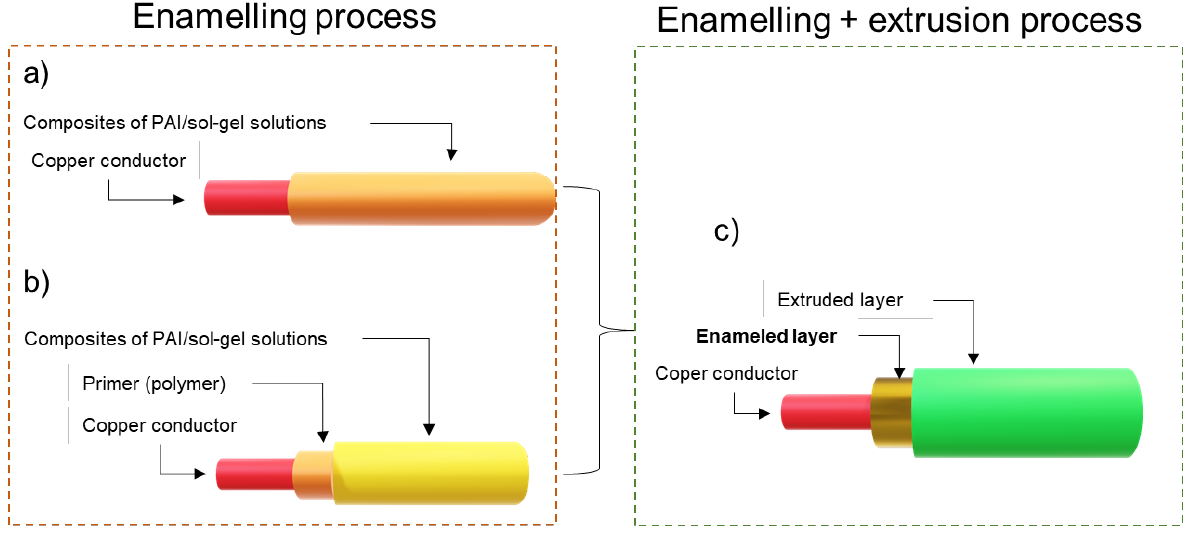
Figure 2. Wire insulation structures. ( a ) Enameled layer structure of composites of PAI/sol-gel so- lutions. ( b ) Enameled layer structure composed of a polymer primer and second layer composites of PAI/sol-gel solutions. ( c ) The global structure, enamel, and extrusion coat.